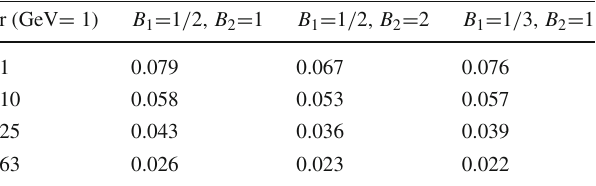
Table 2 Numerical value for the slope μ in GeV for Y = 10 and for different values of B 1 and B